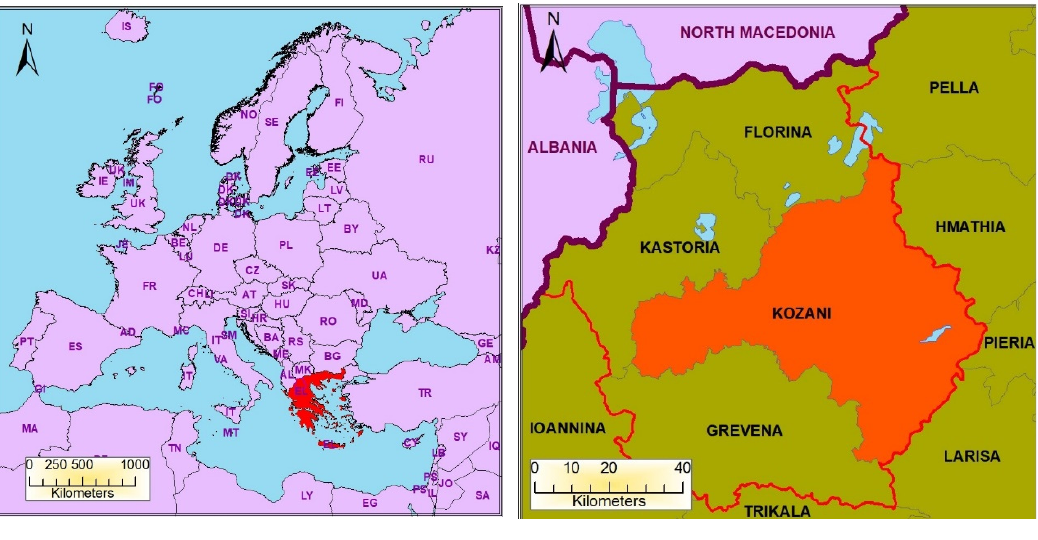
Figure 2. Maps of Europe and region of Western Macedonia—City of Kozani. Source: Authors’ scheme.